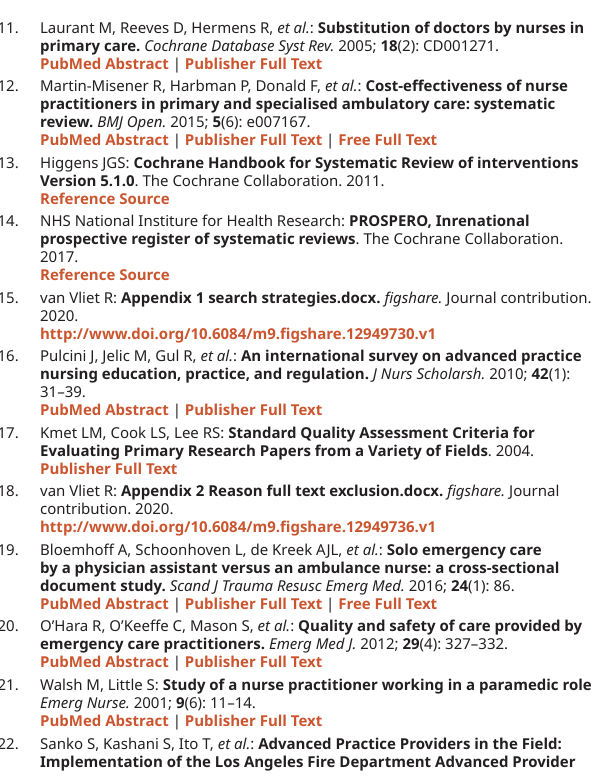
Figshare: Appendix 3 Quality of quantitative studies